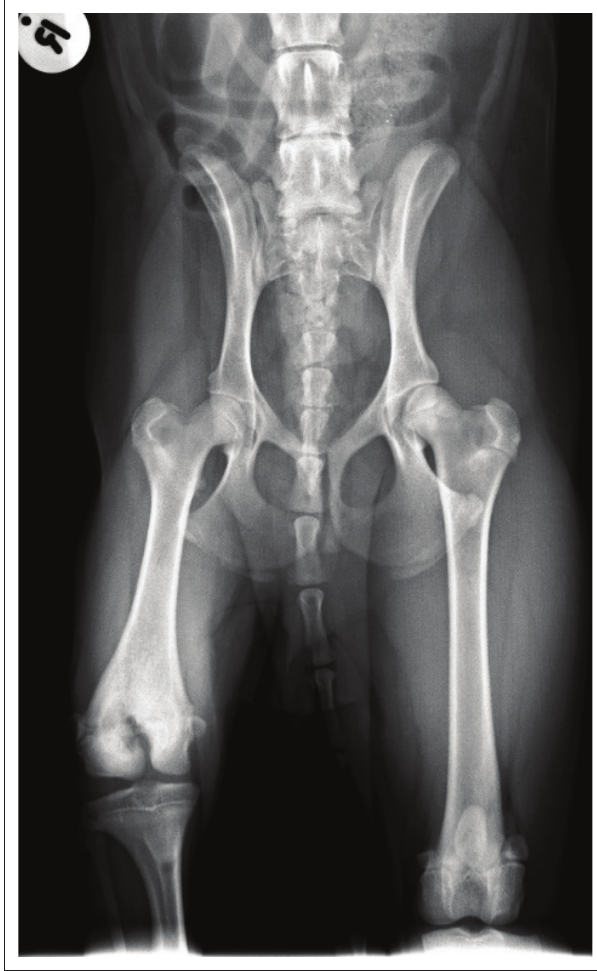
FIGURE 1: Radiographic image: Preoperative ventrodorsal view of the